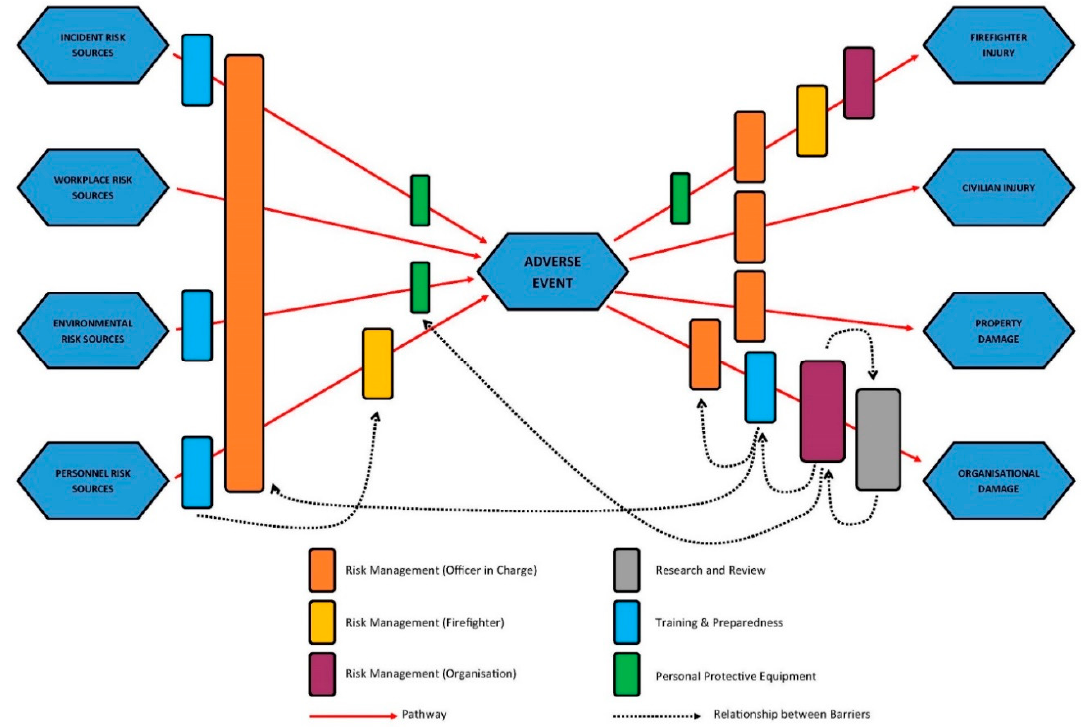
Figure 1. Simplified bow tie analysis contextualised to firefighting operations.